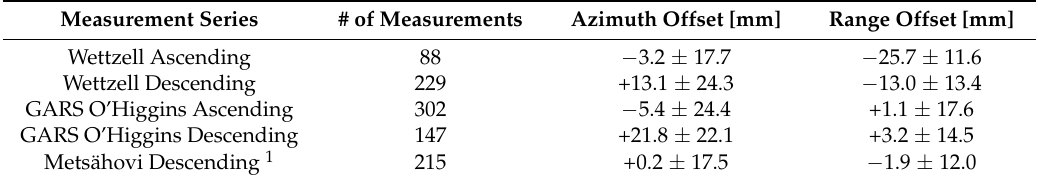
Table 6. CR wise mean values and deviations (1 σ ) of the obtained range and azimuth error. Measurement Series # of Measurements Azimuth Offset [mm] Range Offset [mm] Wettzell Ascending 88 − 3.2 ± 17.7 − 25.7 ± 11.6 Wettzell Descending 229 +13.1 ± 24.3 − 13.0 ± 13.4 GARS O’Higgins Ascending 302 − 5.4 ± 24.4 +1.1 ±